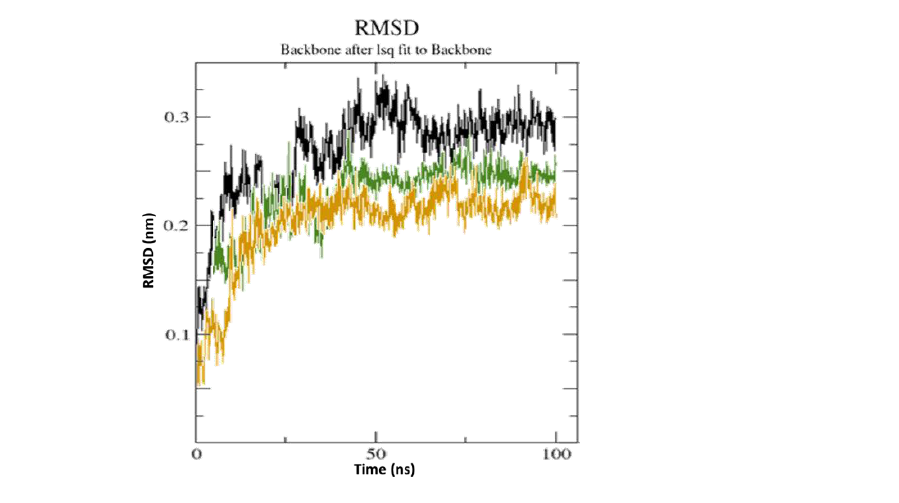
Figure 10. RMSD data of unbound serotonin receptor (black), (FXN)–serotonin (green), and [(FXN)(PA)]–serotonin (brown) at 100 ns.